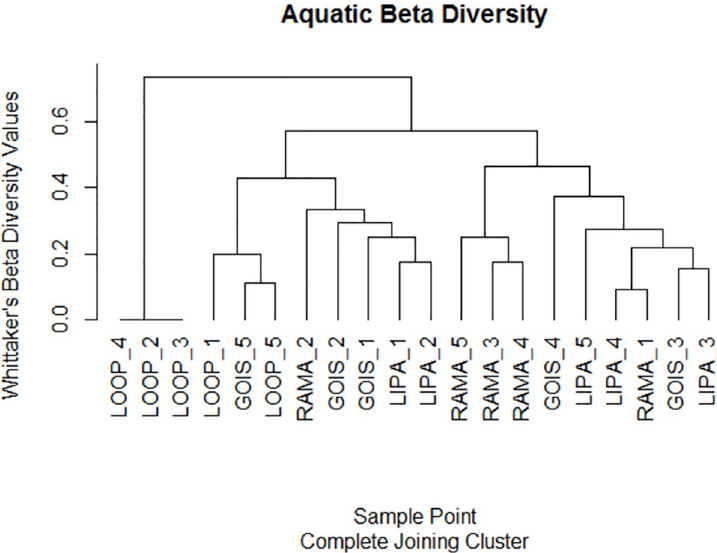
Fig 4. Cluster dendrogram of aquatic bird communities at the 20 study points based on Whittaker’s beta diversity metric. Communities that are closer together in the dendrogram have more similar species composition. The height of the “fork” indicates Whittaker’s beta diversity value between two study